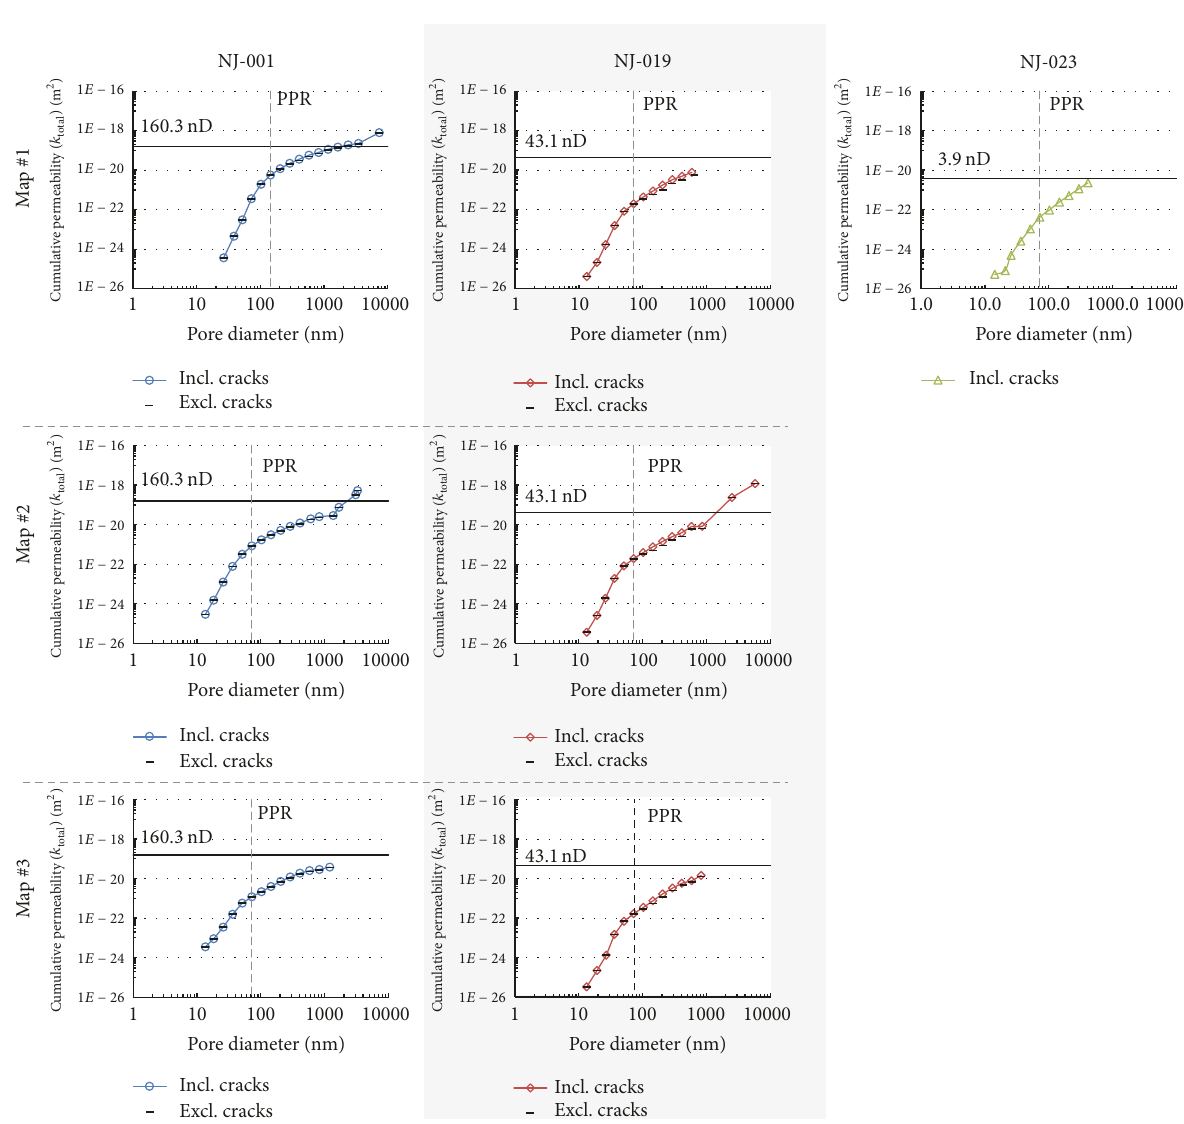
Figure 12: Results of the capillary tube model (predicted permeabilities), indicating the importance of pore sizes when adding up the single permeabilities within each pore bin size. Solid lines mark the experimentally derived permeabilities.